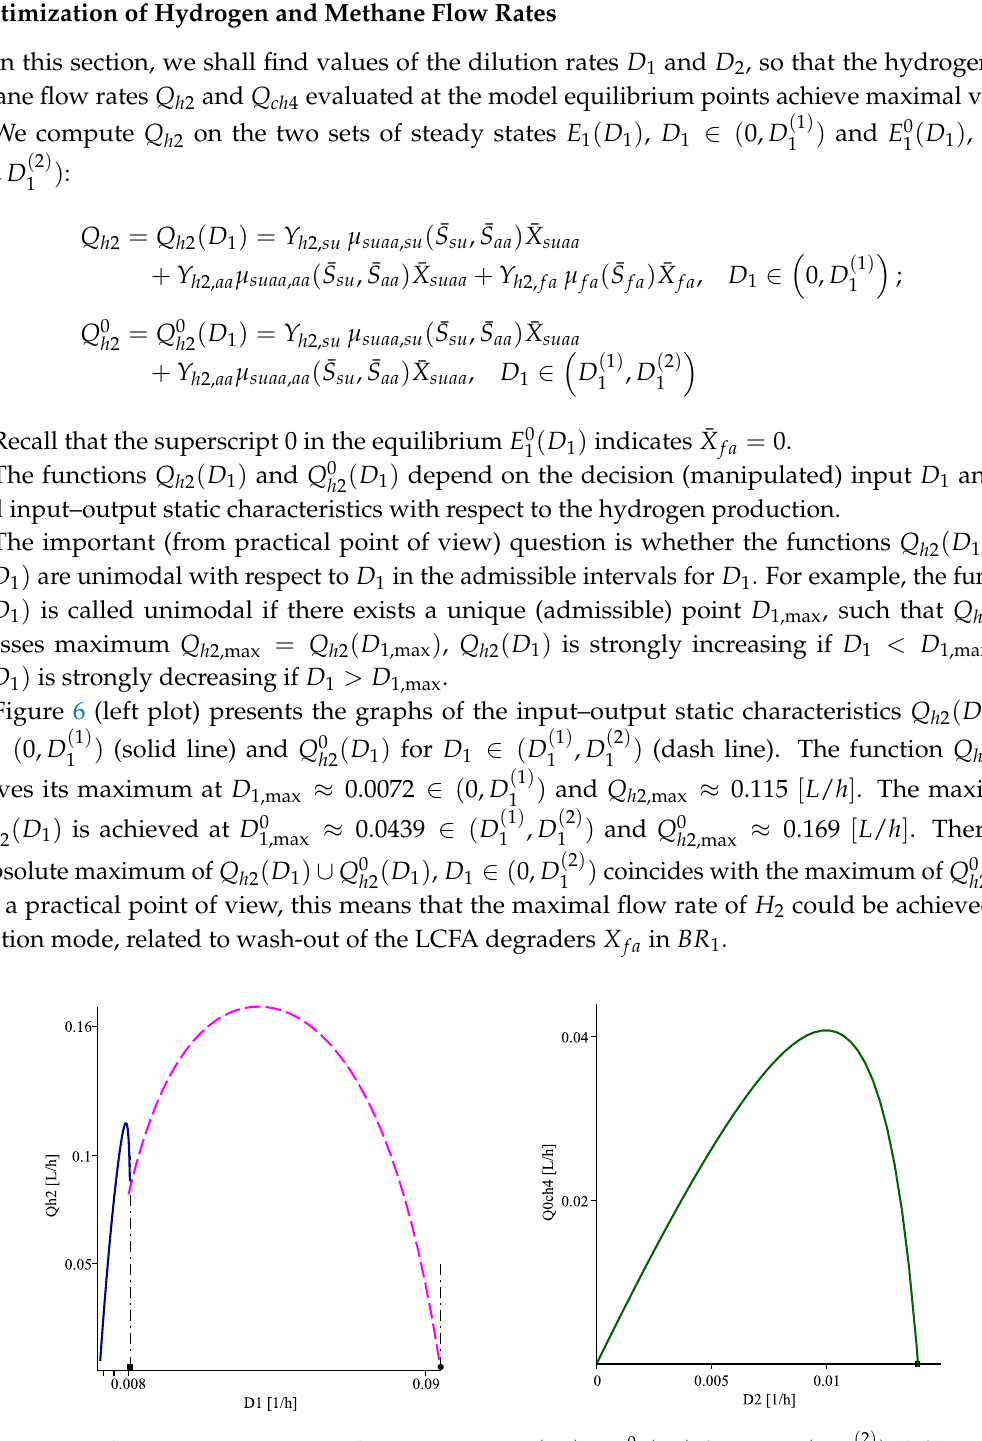
Figure 6. The input–output static characteristics Q h 2 ( D 1 ) ∪ Q 0 ( 1 ) ( D 0 ) (right). The vertical dash-dot lines in the left plot pass through Q 0 , D 2 ) for D 2 ∈ ( 0, D 2 1, max ch 4 ( 1 ) ( 2 ) D (solid box) and D (solid circle). In the right plot, D 1 1